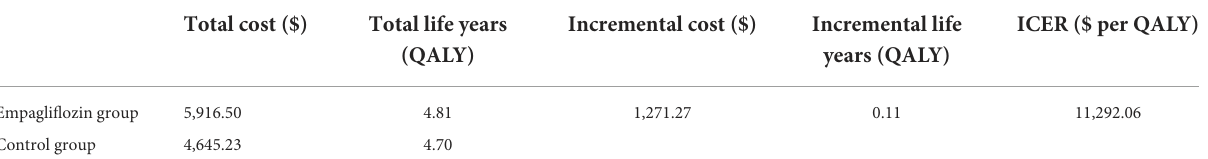
TABLE 3 The results from base-case analysis.